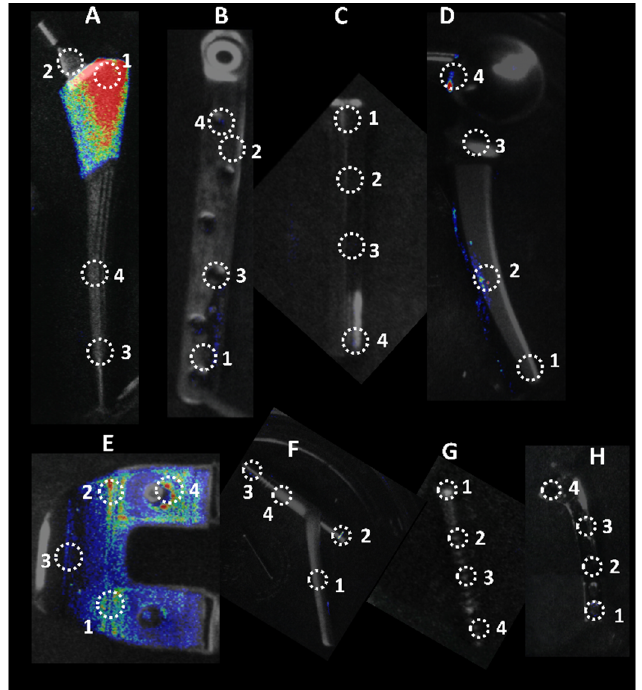
Figure 3. Locations of luminescence measurements. Circle diameters of 30 × 30 pixels were used to measure luminescence on eight different implants. Each location represents a different feature on the implant. A. Femoral Hip Stem; B. 5in Fixation Plate; C. Modular Stem; D. Hip Replacement Ball Joint; E. Total Knee System; F. Sliding Hip Screw; G. Ti Screw; H. 3in Fixation Plate.